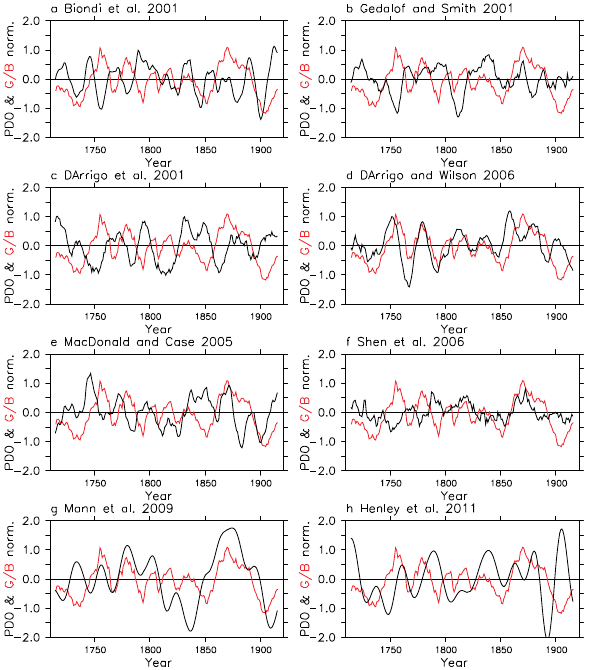
Fig. 3. Comparison of the higher frequency MASB G/B data (as represented in Fig. 2b) for 1709–1920 ( a – h ; red line), with a variety of reconstructed PDO indices (black line), including the (a) Biondi et al. (2001), (b) Gedalof and Smith (2001), (c) D’Arrigo et al. (2001), (d) D’Arrigo and Wilson (2006), (e) MacDonald and Case (2005), (f) Shen et al. (2006), (g) Mann et al. (2009) and (h) Henley et al. (2011) records. The MASB G/B data were stan- dardised and all reconstructed PDO time series were detrended and subsequently standardised prior to the analysis. An 11yr running average was applied to both the MASB G/B and PDO time series in order to visualise the interdecadal and multidecadal changes.